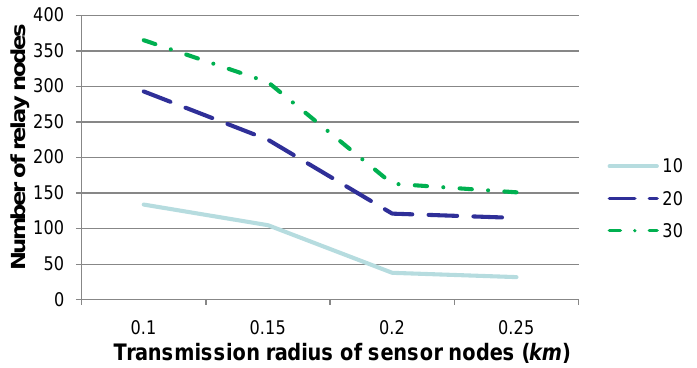
Figure 2. Comparison of the number of relay nodes when the transmission radius r is set to various values, where 10, 20 and 30 specify the number of time slots for our experiments. This figure shows that the number of relay nodes declines when the transmission radius is set to a relatively large